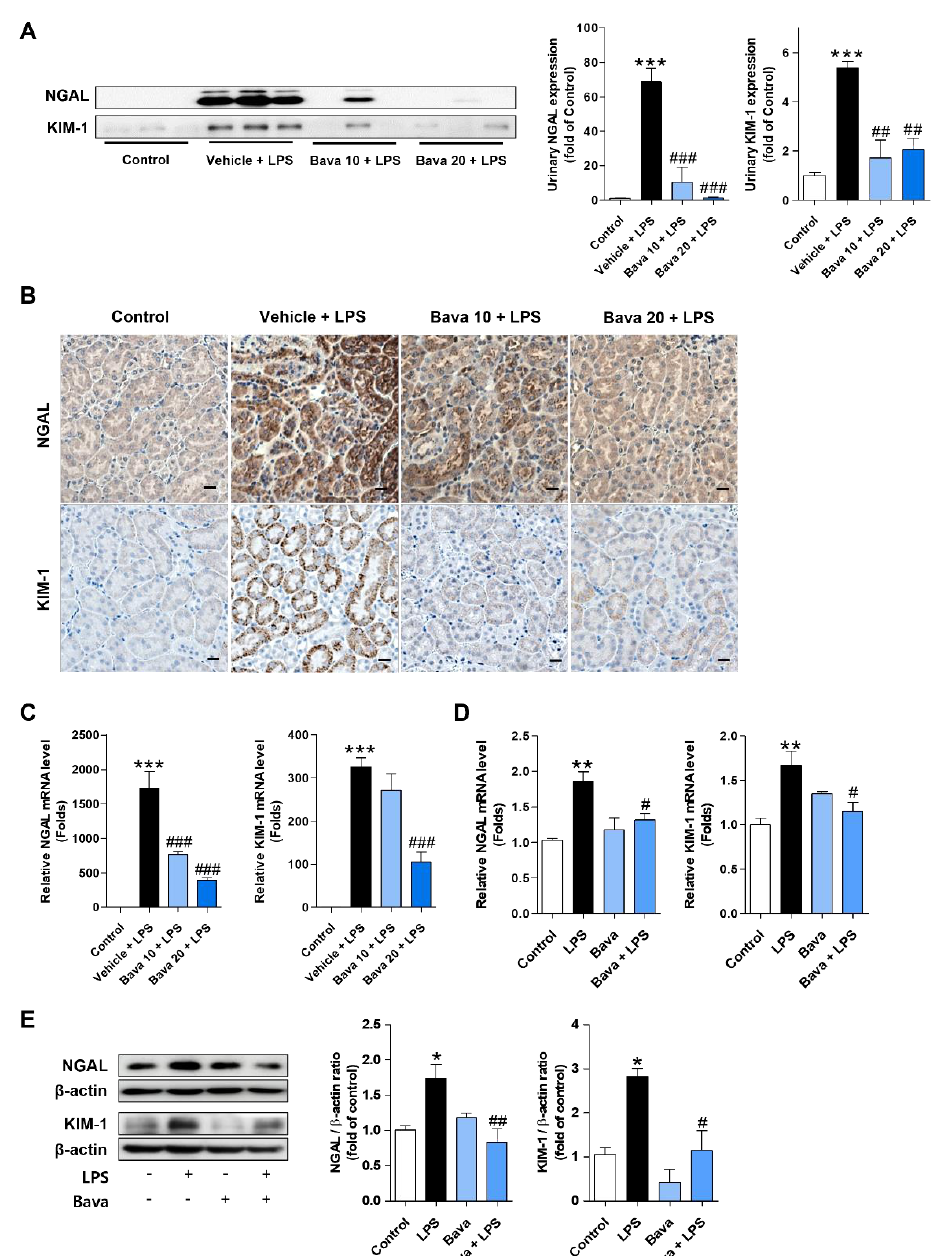
Figure 2. Bavachin decreases the expression of NGAL and KIM-1 in LPS-induced AKI mice and LPS-treated HK-2 cells. ( A – C ) After 24 h of LPS injection, mice were sacrificed and kidney tissues and urine were collected. ( A ) The urine protein levels of neutrophil gelatinase-associated lipocalin (NGAL) and kidney injury molecule-1 (KIM-1) were analyzed by Western blotting and quantified using ImageJ software ( n = 3 mice per group). ( B ) Immunohistochemical detection of NGAL and KIM-1 was performed in kidney tissues using DAB. Nuclei were counterstained with hematoxylin (original magnification, 200 × ; scale bars, 20 µ m; n = 3 mice per group). ( C ) The mRNA levels of NGAL and KIM-1 in the kidney tissues were analyzed by qRT-PCR ( n = 5 mice per group). ( D , E ) HK- 2 cells were pretreated with 0.1 µ g/mL bavachin for 1 h and then treated with 1 µ g/mL LPS for 15 h. ( D ) The mRNA levels of NGAL and KIM-1 were analyzed by qRT-PCR ( n = 3). ( E ) Protein levels of NGAL and KIM-1 were analyzed by Western blotting, quantified using ImageJ software, and normalized to β -actin ( n = 3). Data are presented as mean ± SEM. * p < 0.05, ** p < 0.01, *** p < 0.005 vs. control; # p < 0.05, ## p < 0.01, ### p < 0.005 vs. vehicle + LPS or